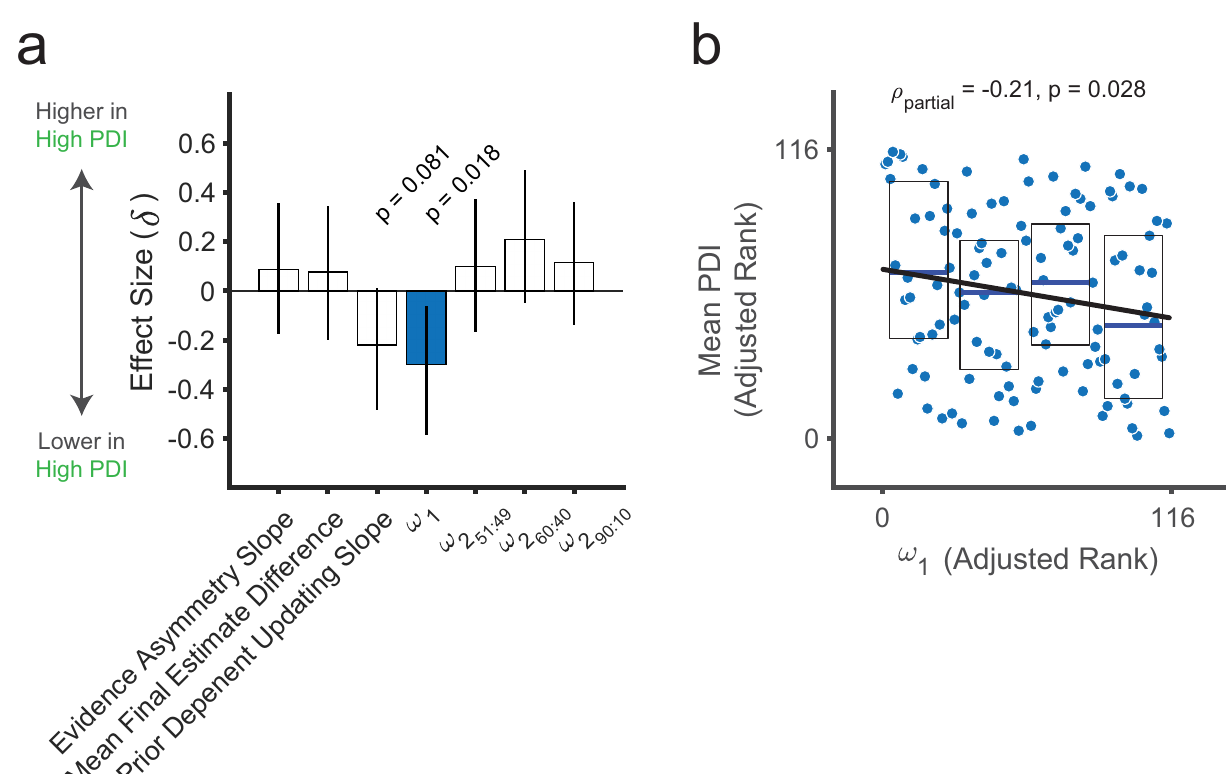
Fig 5. Prior underweighting relates to belief oddity outside the laboratory. (a) Summary of group-level differences (S22 Table) for model-based and model-agnostic measures between the low (n = 57) and high (n = 34) PDI groups. Bar plots are effect size (Cliff’s delta, δ ) and 95% confidence intervals. (b) Scatterplot showing a negative correlation between ranked mean PDI scores and ω 1 (n = 116). Values are adjusted by o (RMSE) for specificity as in the partial Spearman correlation analysis. Boxplots show medians (blue lines) and 25 th and 75 th percentiles (bottom and top edges, respectively). The solid black line reflects the least-squares linear fit to the data points. Mean PDI is the average of the global PDI scores across the pre- screening and the experimental sessions for each